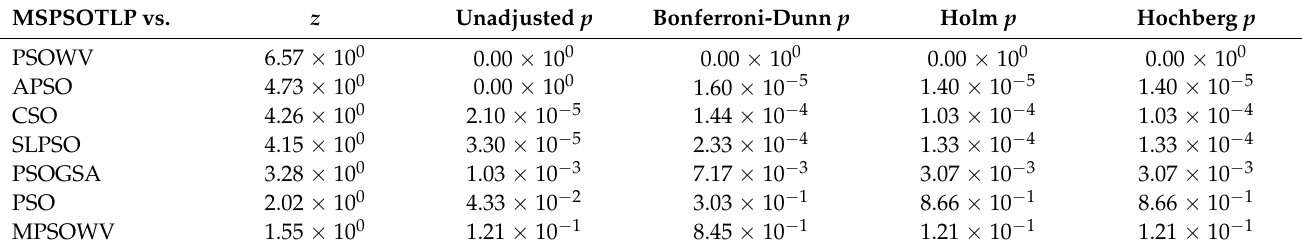
Table 18. Adjusted p values produced by trained ANN models in solving testing samples through three post-hoc analysis